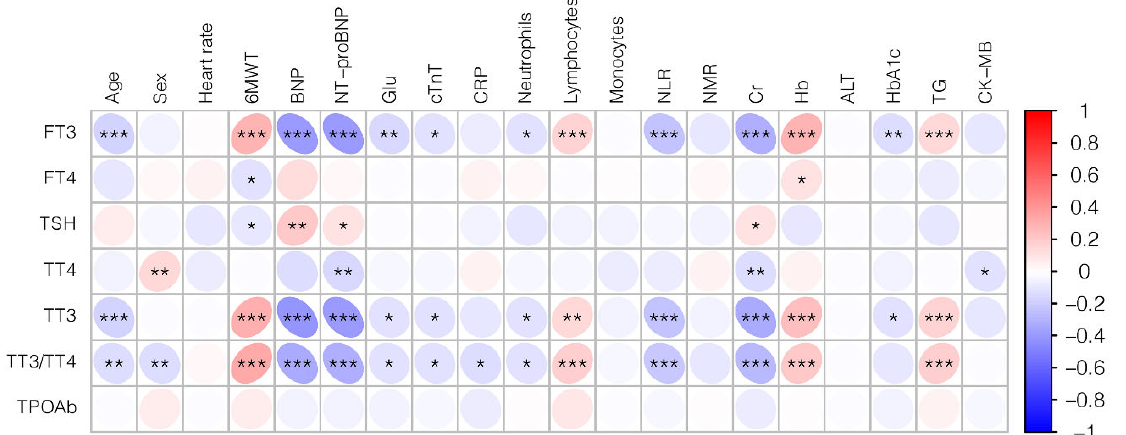
Figure 2. The correlation between thyroid hormones, inflammation values, and cardiac parameters in HF patients. Negative correlations are shaded blue, while positive correlations are shaded red. The strength of the correlation is indicated by dot gradient and color saturation. * p < 0.05, ** p <